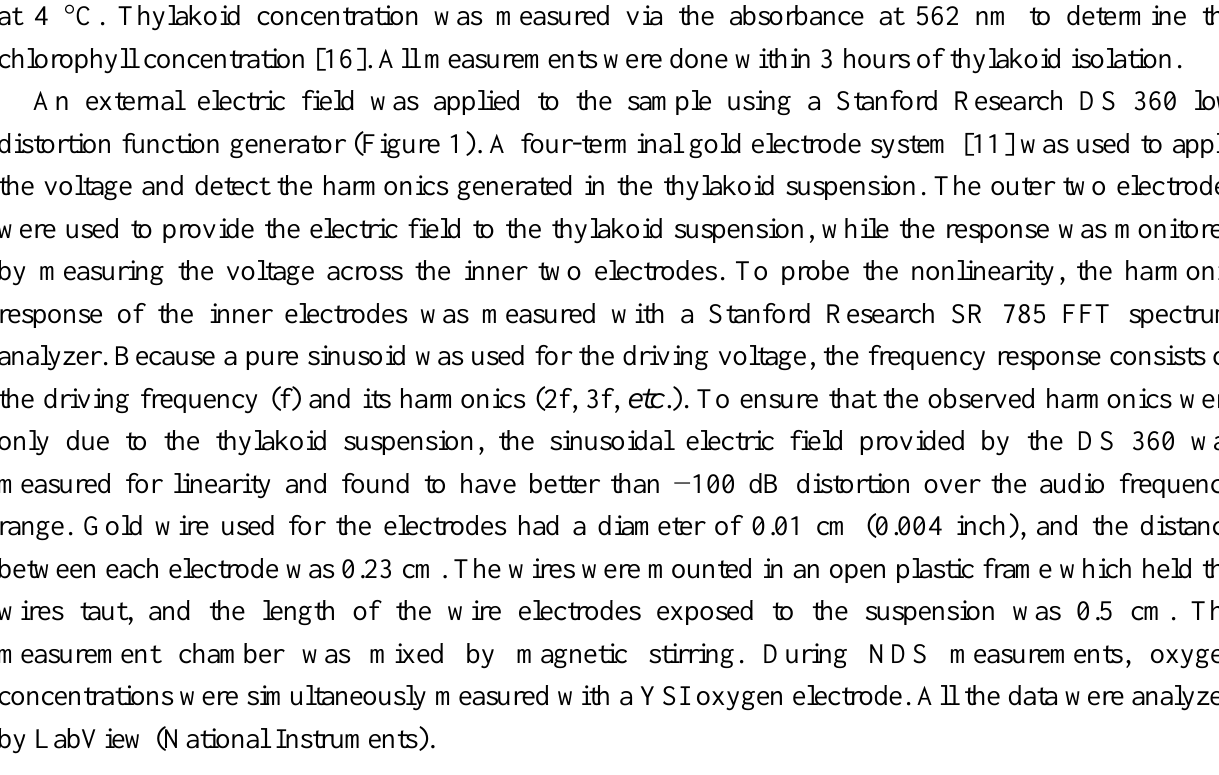
Figure 1. Four-probe measurement setup used to measure nonlinear dielectric spectrum and oxygen concentration (oxygen sensor not